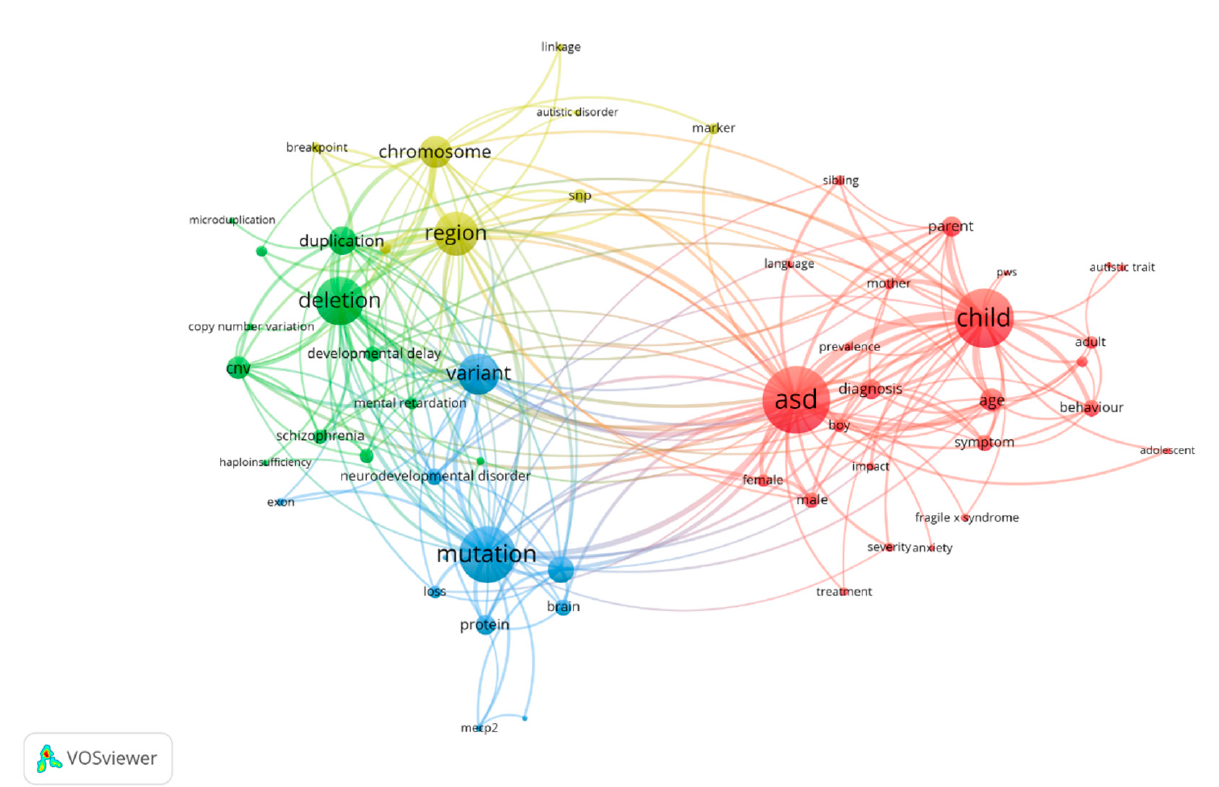
Figure 6. Co-occurrence network of terms of genetic factors in ASD publications from 1997 to 2018. The most common terms used in the scientific literature were investigated to identify relationships between the extracted terms and new aspects and the applied technologies. Terms were automatically exacted from titles and abstracts and divided into four clusters by the natural language processing techniques of VOSviewer.